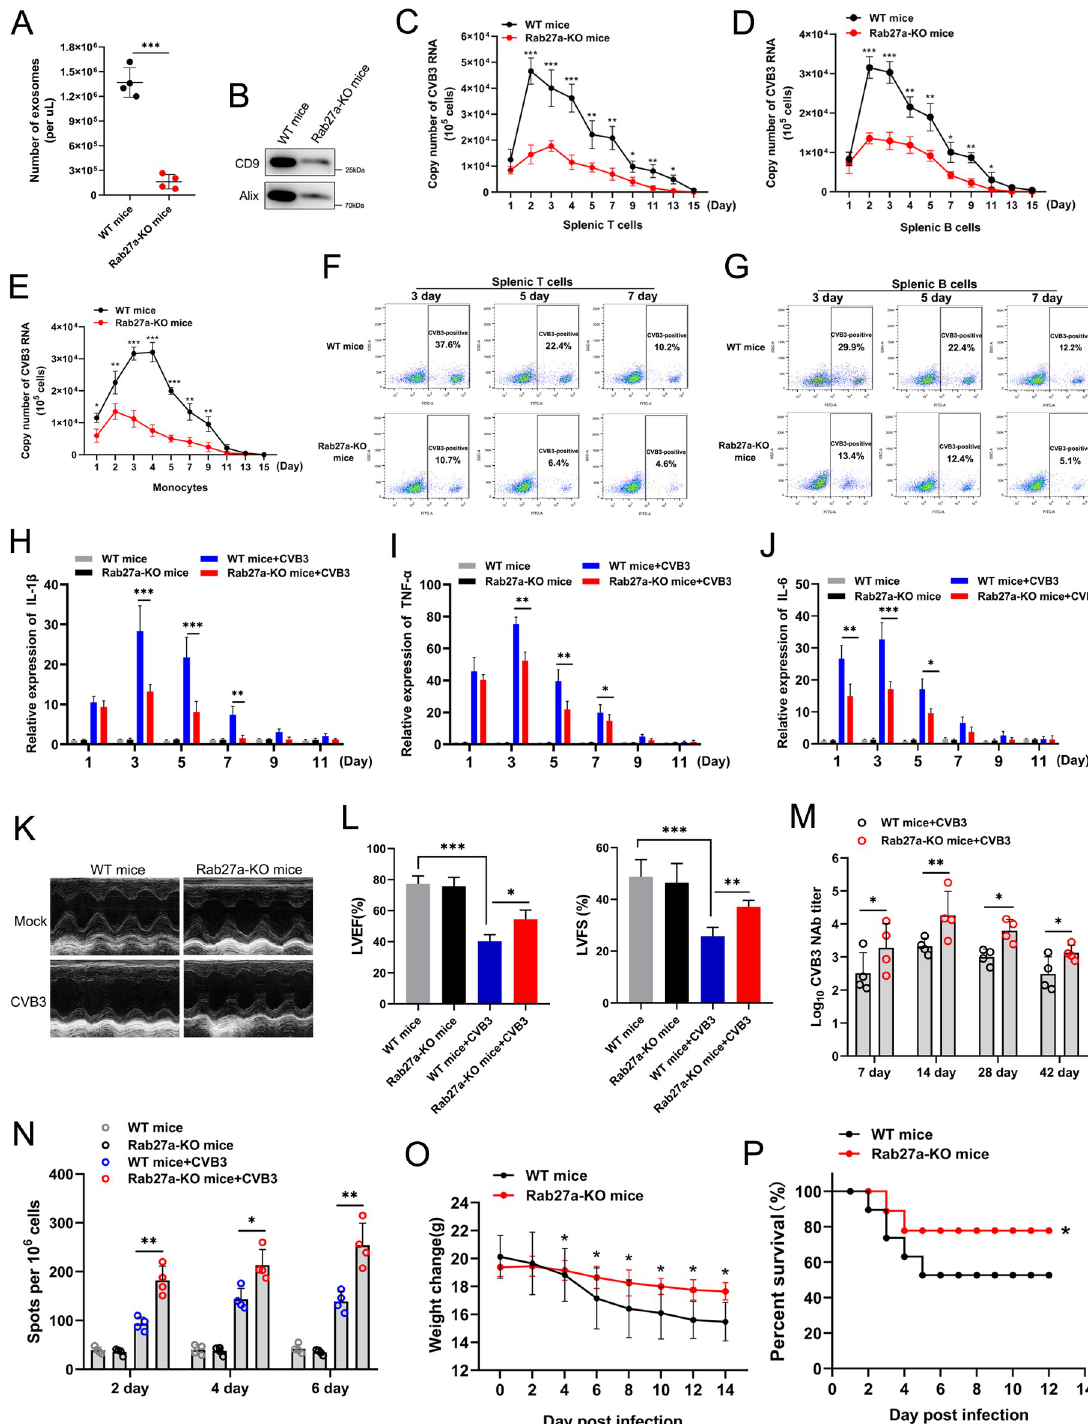
Fig 7. Inhibition of exosomes coupling with CVB3 attenuated the pathogenetic events in vivo . (A and B) The exosomes isolated from wild-type (WT) or Rab27a-KO mice of serum was quantified using NTA(A) and western blot(B). Each group contained 5 mice. (C, D and E) Real-time PCR data for the comparison of CVB3 RNA expression level in splenic T(C), splenic B(D) and monocytes(E) cells in WT or Rab27a-KO mouse at various time points. Six weeks-old of Rab27a-KO mice or WT mice were orally inoculated after fasting at 5 × 10 6 TCID 50 per mouse. n = 5 biologically independent animals per group. (F and G) The percentage of CVB3-infected splenic T(F) and splenic B(G) cells were determined by flow cytometric analysis at indicative time points. Cells were stained with anti-CVB3 and Alexa